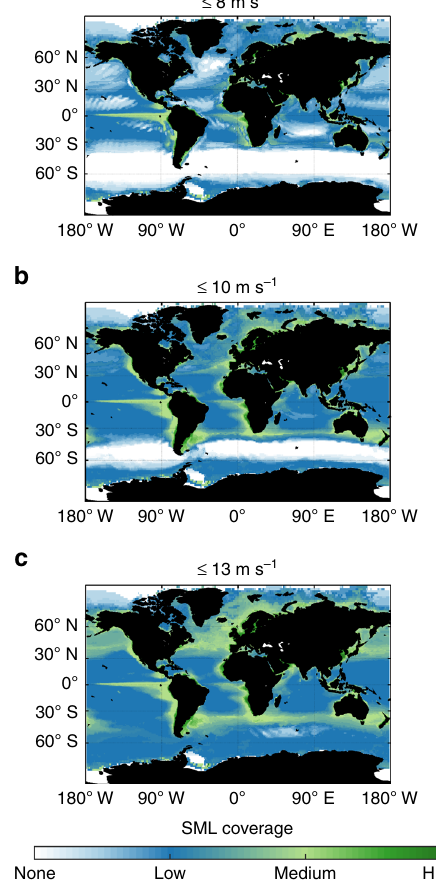
Fig. 1 Average annual sea surface microlayer coverage of the surface of the oceans. a – c Demonstrate the effect of different wind speed limits on the predicted global surface coverage. In particular, the North Atlantic and North Paci fi c as well as the Southern Ocean react rather sensitive to the chosen threshold